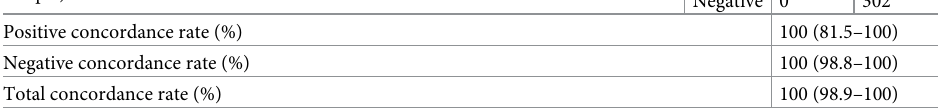
Data in parentheses are 95% confidence